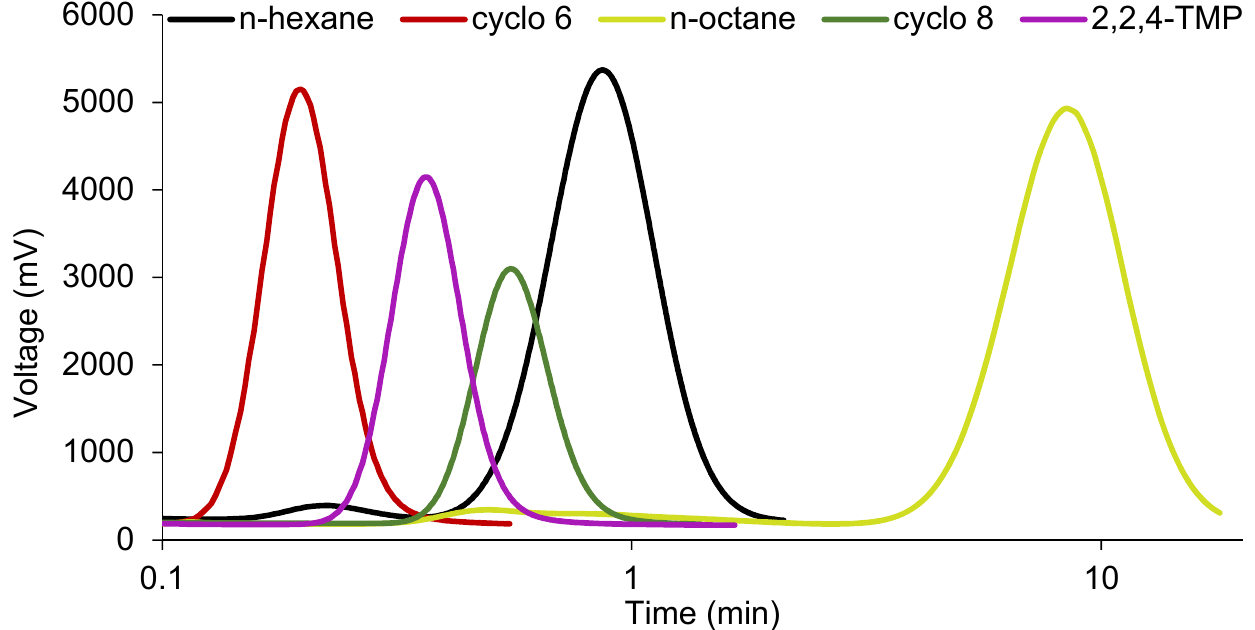
Figure 4. Examples of chromatograms for the elution of n -hexane, cyclohexane (cyclo 6), n -octane, cyclooctane (cyclo 8), and 2,2,4-trimethylpentane (2,2,4-TMP) in sepiolite 2 at 240 °C (flow rate of 63 mL min − 1 ). Due to large differences between probes in the values of retention times, these are shown on a logarithmic scale for a better visualization.